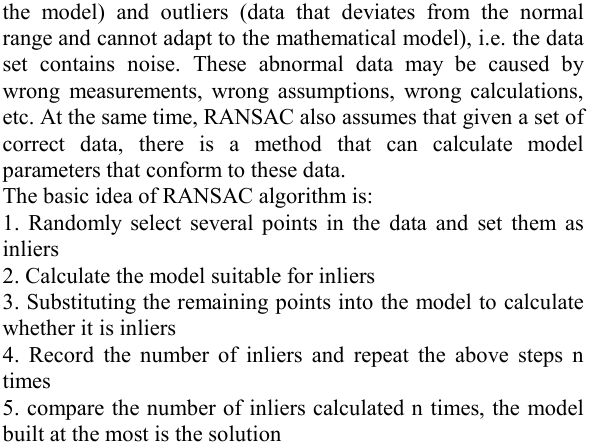
SURF algorithm filters the original image by defining templates